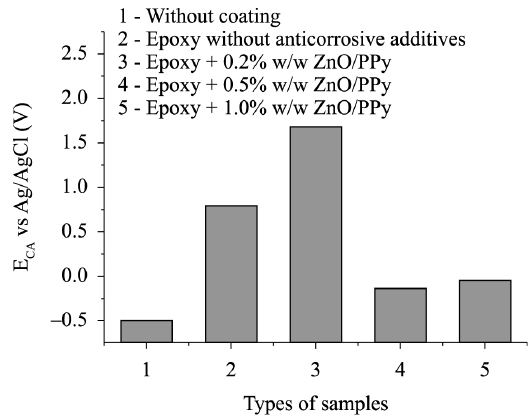
Figure 5. Corrosion potential of coated and uncoated metal obtained by